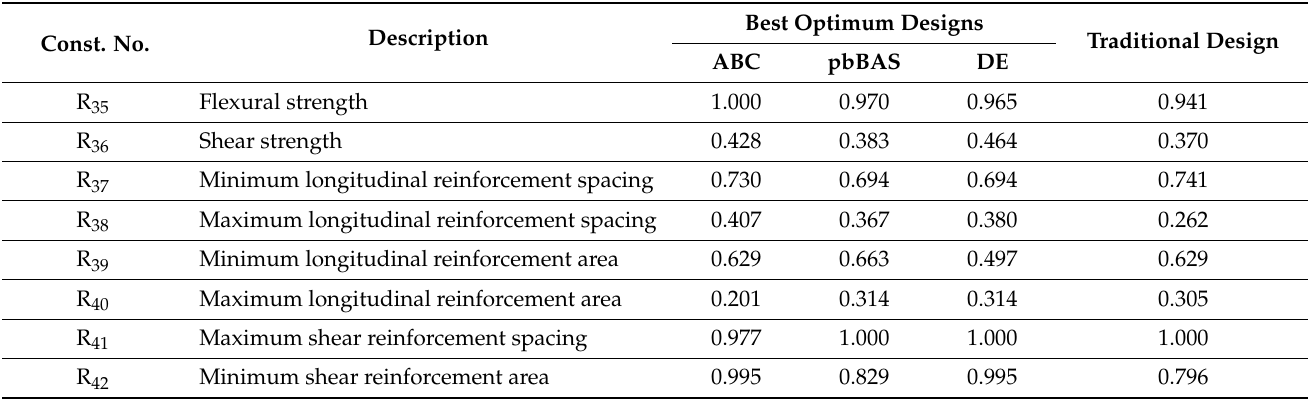
Table 29. The maximum demand capacity ratios of columns constraints in the optimum design achieved by each metaheuristic algorithm for the three-segment type folded plate roof building.